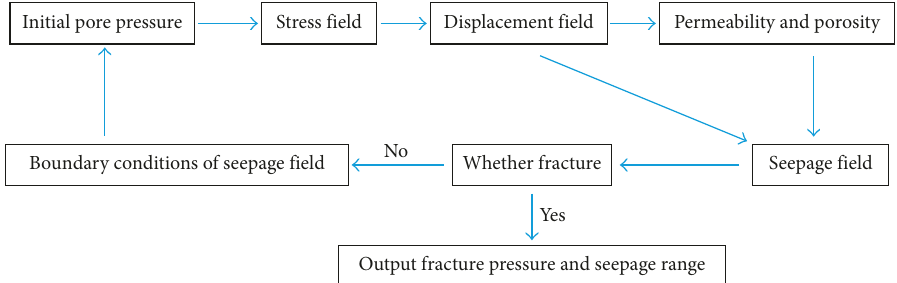
Figure 11: The flow chart of simulation.